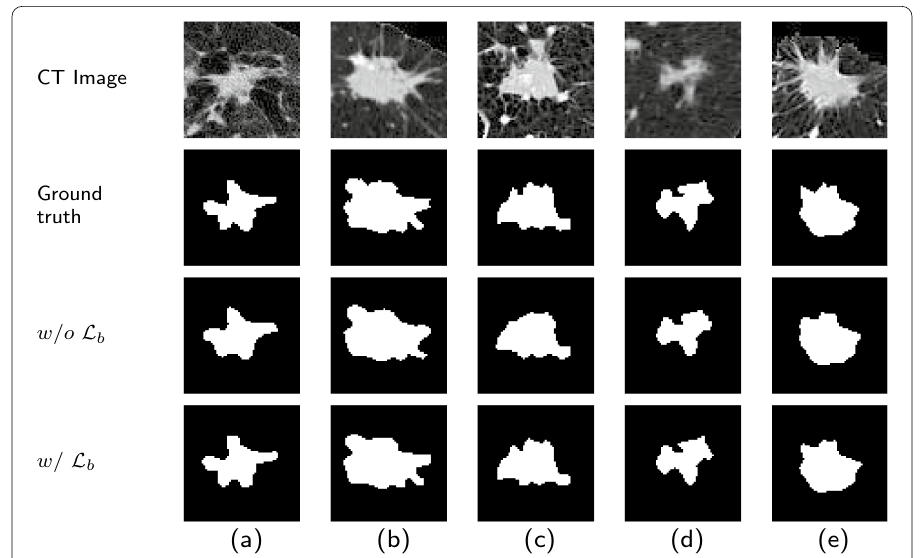
Fig. 12 Illustration from top to bottom represents original CT images, ground truth, segmentation results by the proposed segmentation framework without L b and with L b , respectively. Images a – e refer to five samples, respectively